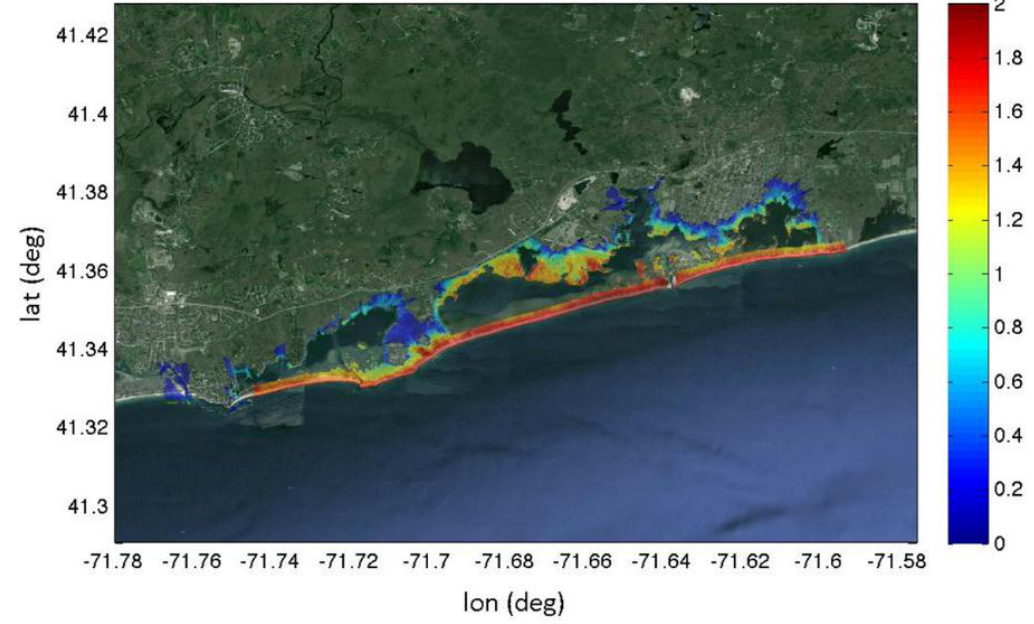
Figure 10. Controlling wave height (m) for Charlestown, RI, 100 year event, dune eroded [20]. The contour scale provided at the right of the figure is in meters.